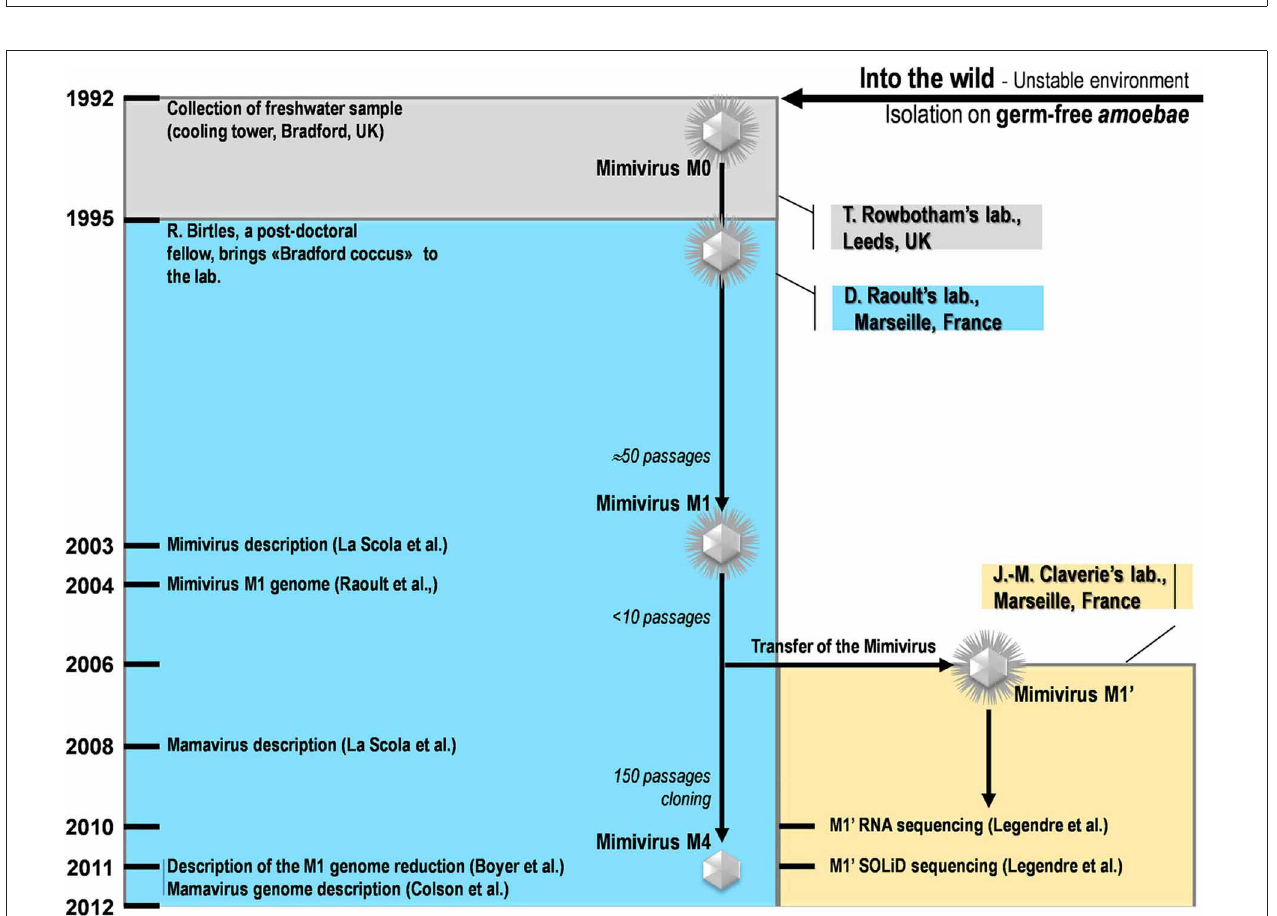
FIGURE 2 | A schematic diagram of the collection, isolation, and experiments conducted for Mimivirus and Mamavirus.